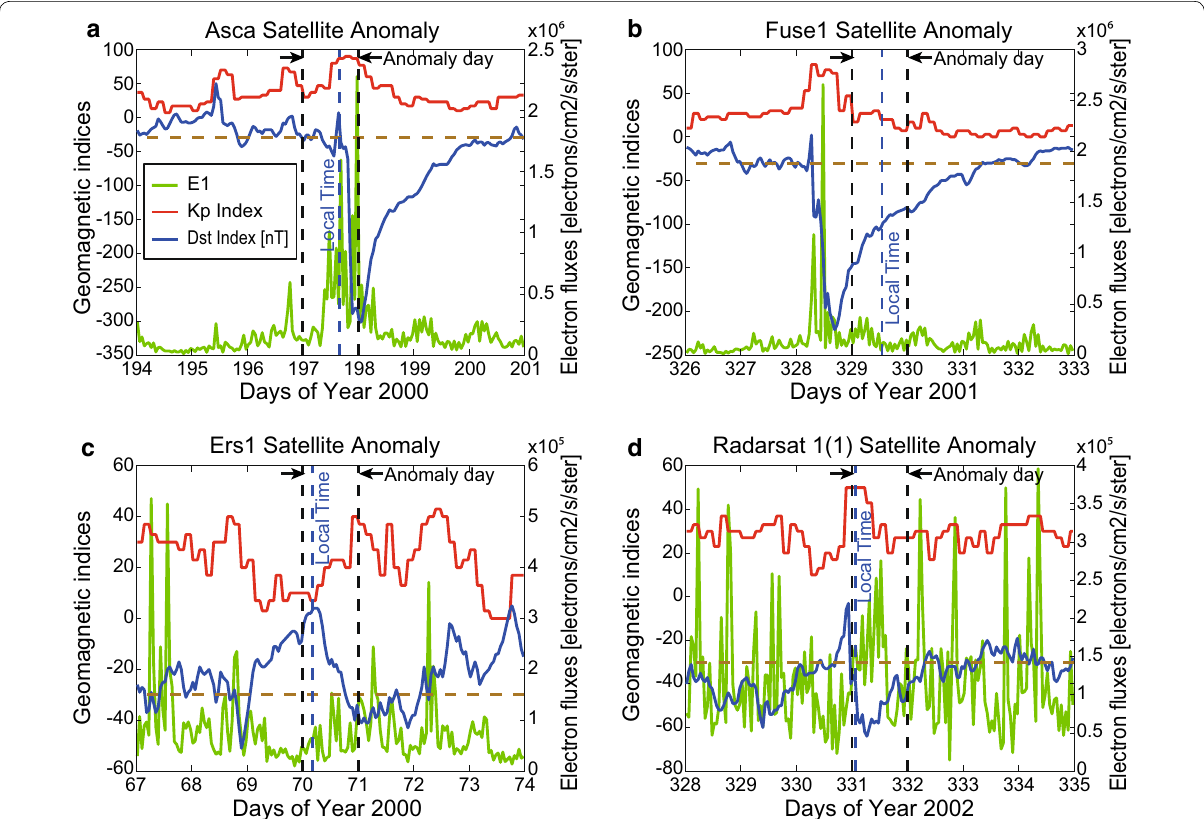
Fig. 4 Variation of electron fluxes and geomagnetic disturbances during the 7-day interval straddling the anomaly day for a ASCA, b FUSE 1(1), c ERS-1, and d Radarsat-1(1). The red, blue, and green curves are the Kp index, Dst index, and electron flux in channel E1,